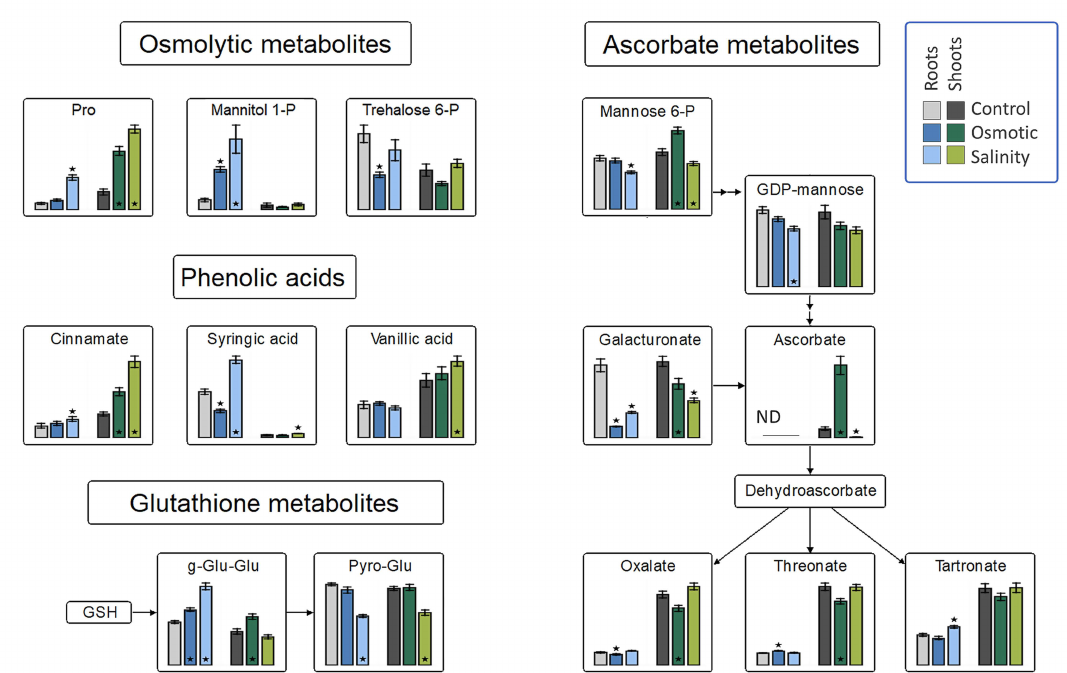
Figure 4. Changes in osmolytic metabolites, and the antioxidant system in roots and shoots of Hordeum marinum under osmotic and salinity stresses. Bars represent means of seven independent replicates ± SE. Significant di ff erences to control treatments at specified time points after excision are indicated by asterisks (Wilcoxon, Mann-Whitney U-test; *, p <